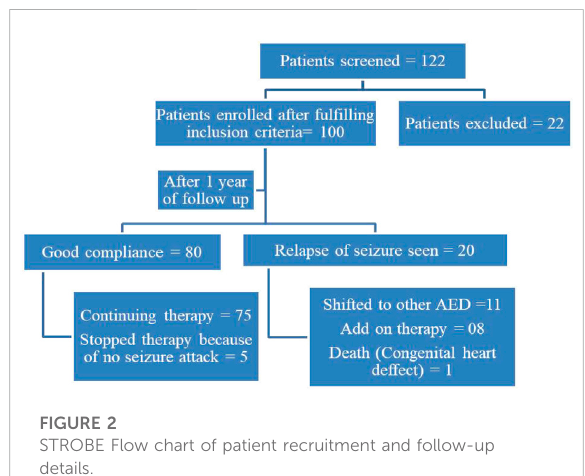
FIGURE 2 STROBE Flow chart of patient recruitment and follow-up